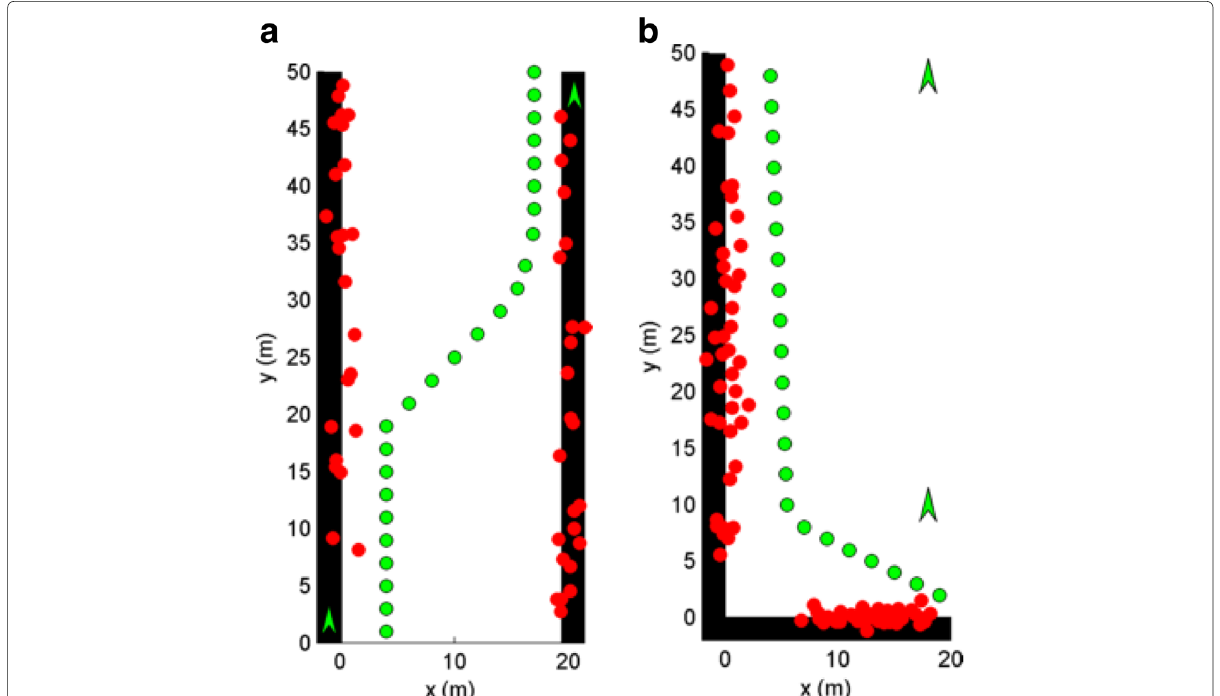
Fig. 10 Mapped scatterer locations (red) generated from GAPF estimator at UE locations (green) on a path through a the urban canyon and b the urban